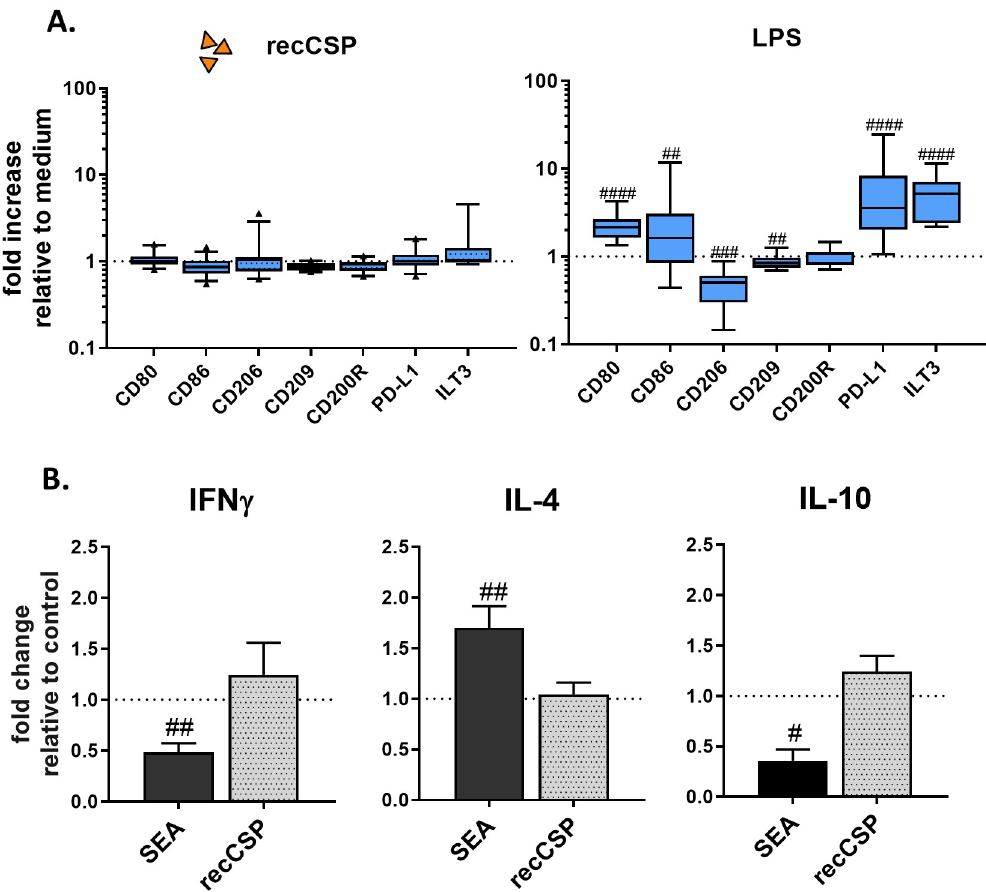
Fig 3. MoDC responses to recCSP. A . RecCSP stimulation (250 ng/ml) does not alter MoDC surface markers. Responses to control LPS are shown on the right. Data shown as fold changes compared to medium stimulated control. N = 8, 10–19 donors per marker. B . CD4 + T cell polarization after recCSP stimulation. RecCSP stimulation of LPS-matured MoDCs does not polarize na ï ve T cells towards a Th1 (IFN γ ), Th2 (IL-4; both measured by intracellular staining, N = 2, 6 donors.) or Treg (IL-10; measured by ELISA after CD3/28 restimulation, N = 2, 4 donors) response. Soluble Schistosome Egg Antigen (SEA) used as a Th2 inducing control. Data shown relative to LPS-matured MoDC control. A and B: # indicates comparison to control. #: P = < 0.05, ##: P = < 0.005, ###: P = < 0.0005 and ####: P = <